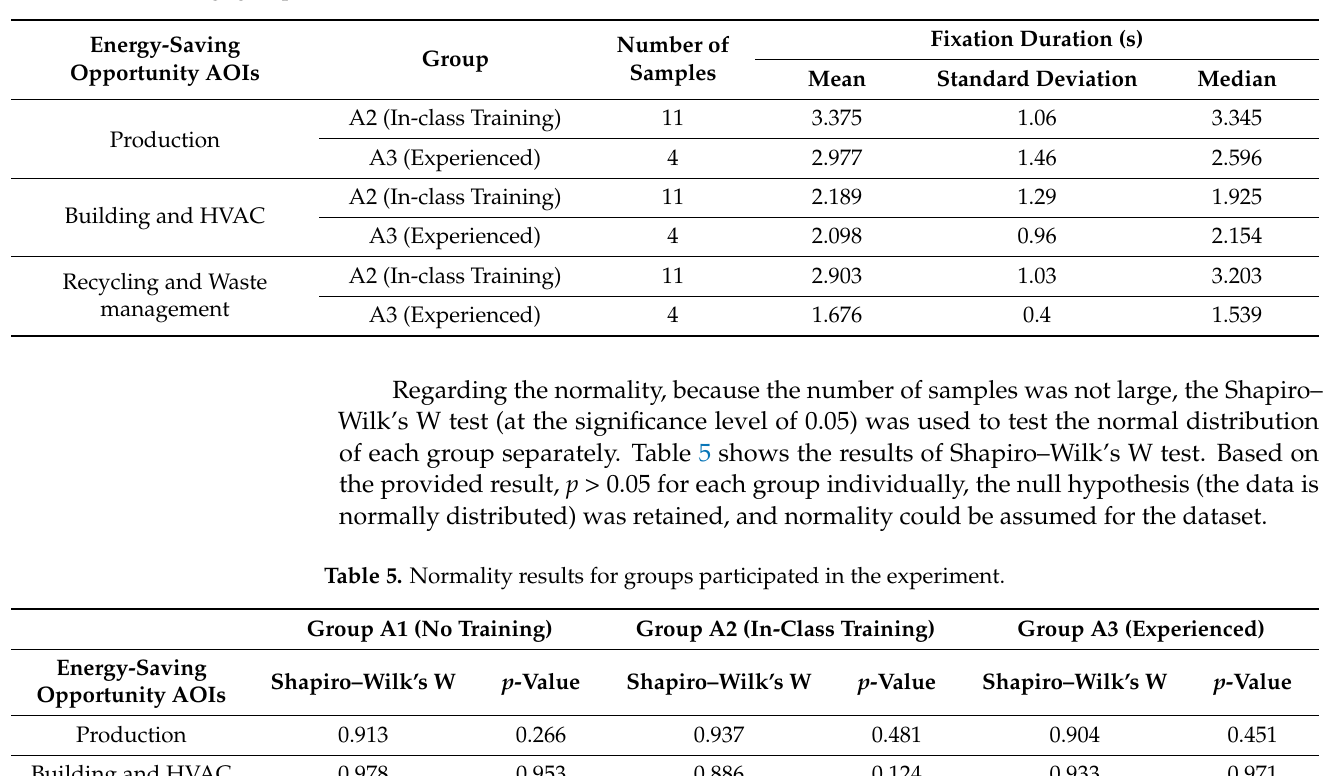
Table 4. Performance of experienced students (group A3) in energy assessment vs. performance of students who received in-class training (group A2).